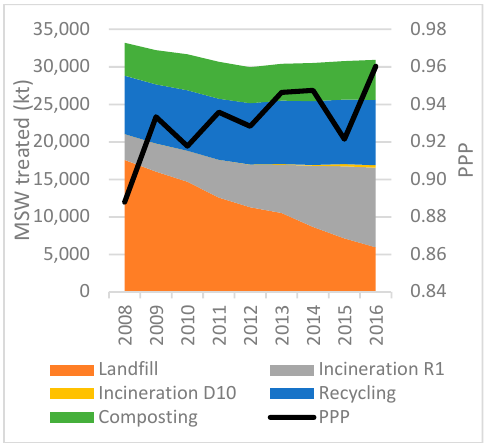
Figure 56. Waste treatment methods and PPP in UK 2008–2016 (EUROSTAT 2019b, 2019c).